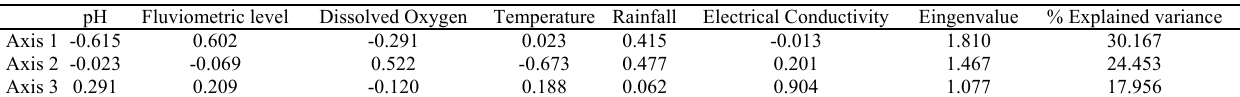
Table 1. Structural coefficients obtained through principal component analysis for axes with eigenvalues greater than 1.0. Values greater than 0.4 were considered as biologically important.